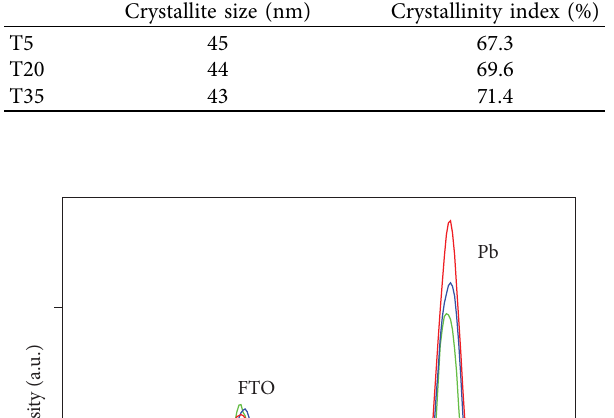
Table 1: Crystallite size and crystallinity index for the samples obtained at 5 ° C (T5), 20 ° C (T20), and 35 ° C (T35). Crystallite size (nm)